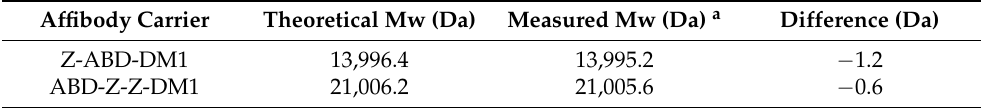
Figure 4. SDS-PAGE analysis of the two-step purified drug conjugates Z-ABD-mcDM1 and ABD-Z-mcDM1 under reducing conditions. The numbers to the left of the gel correspond to the molecular weight (in kDa) of the marker proteins loaded in lane M. Table 3. Theoretical and measured values of the drug conjugates’ molecular weights.